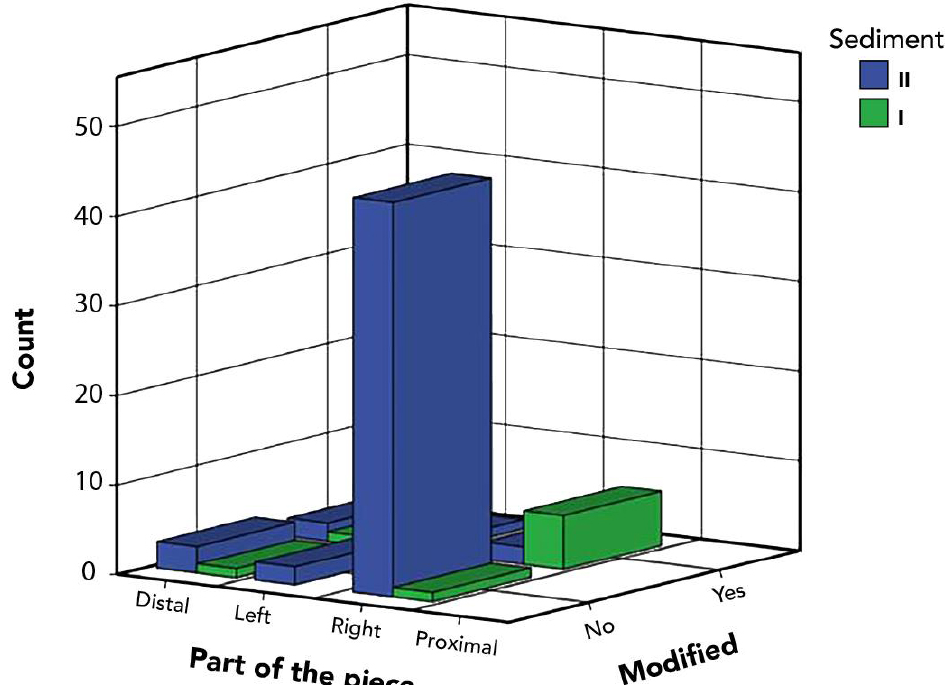
Figure10. Number of starch grains (modified or non-modified) found in the different parts of the